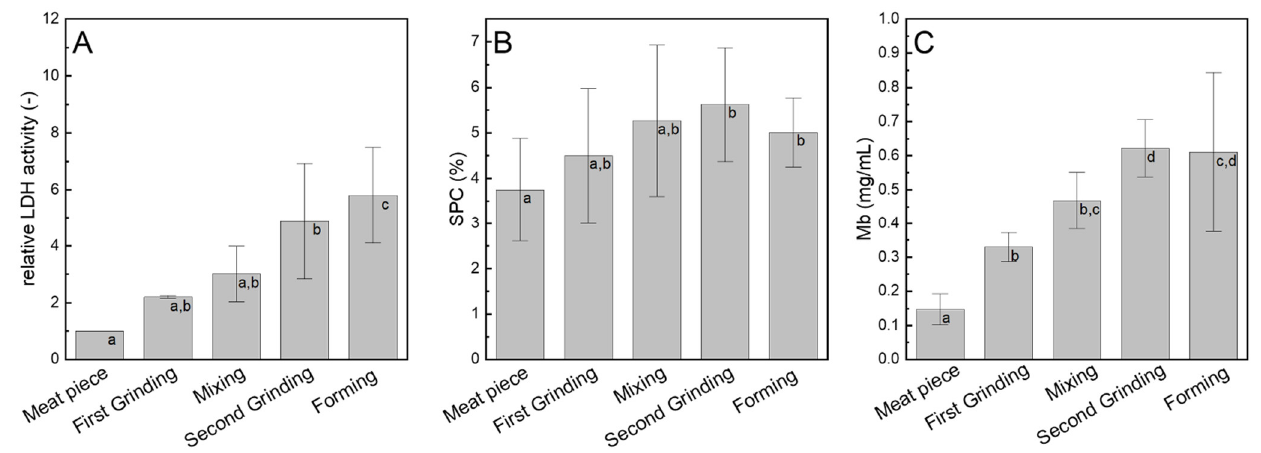
Figure 4. Characterization of the chemical and quality properties: ( A ) relative lactate dehydrogenase activity ( LDH ), ( B ) myoglobin content ( Mb ), and ( C ) soluble protein content ( SPC ) of the extracted meat solutions at different processing stages. Data points with different letters are significantly different ( p < 0.05), n = 3.